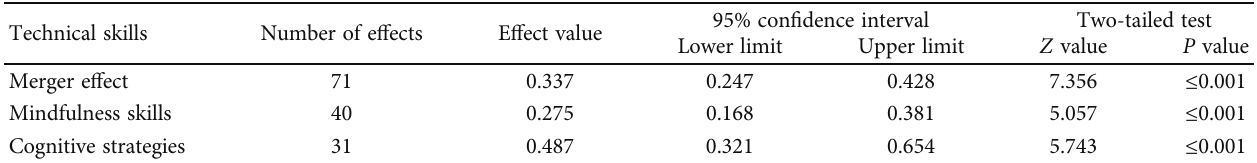
Table 3: Learning e ff ects of VR on di ff erent technical skill measurement dimensions.